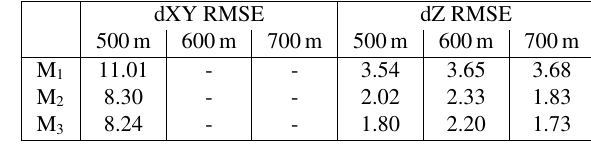
Table 3. RMSE of the discrepancies between refraction corrected ALS data and terrestrial reference data in percent of the water